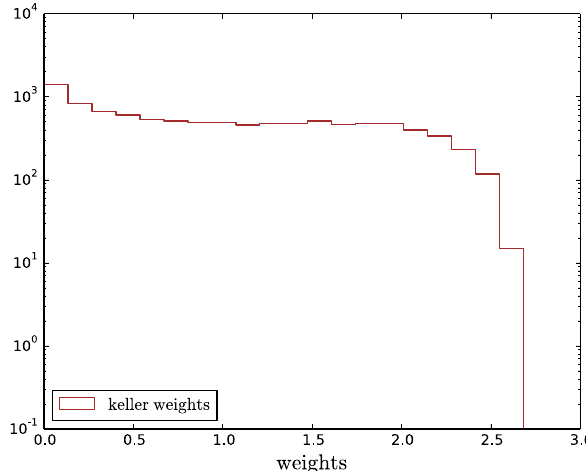
Fig. 20 Weight distribution after reweighting using the lepton charge asymmetry and forward–backward asymmetry from CMS W ± produc- tion